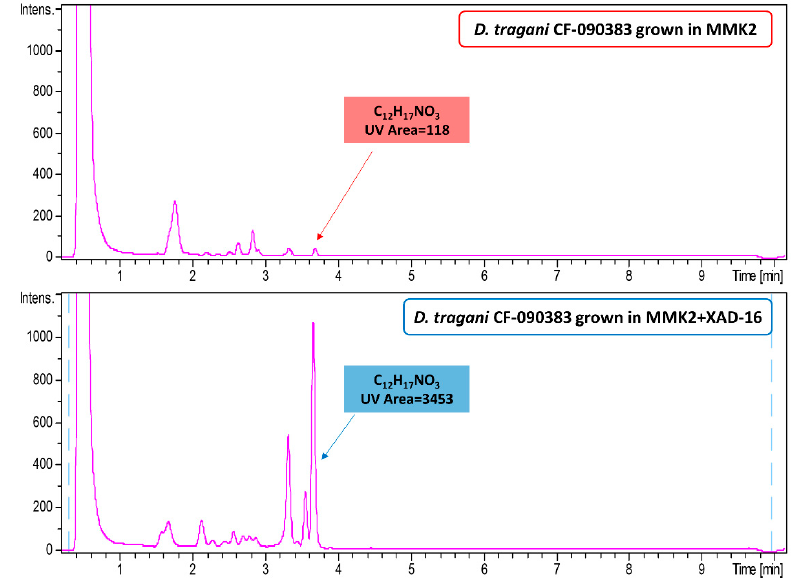
Figure 3. Comparison of HPLC-UV (area at 210 nm) chromatograms of D. tragani CF-090383 extracts from the strain grown in MMK2 medium vs. MMK2 medium + XAD-16